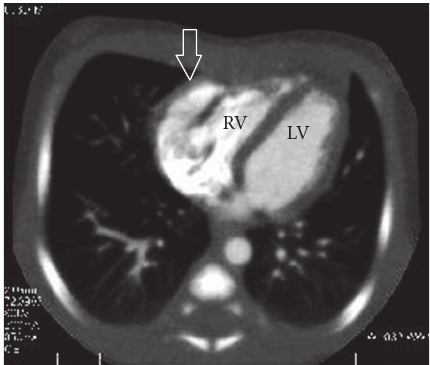
Figure 4: Postnatal computed tomography scan showing myocardium in the diverticulum arising from the right ventricle. LV, left ventricle; RV, right ventricle. Arrow indicates the